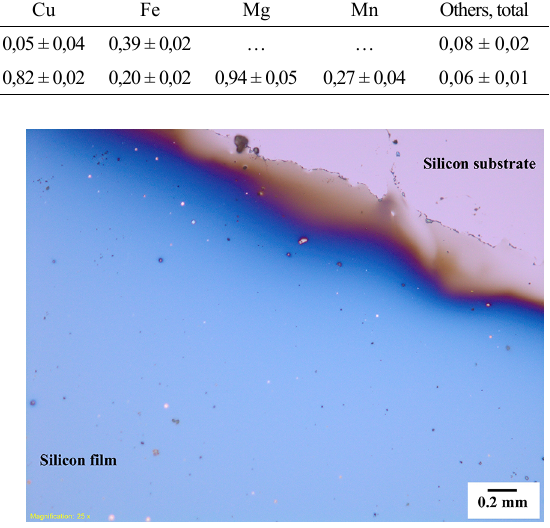
Figure 2. Optical microscopy of silicon film deposited on silicon substrate.